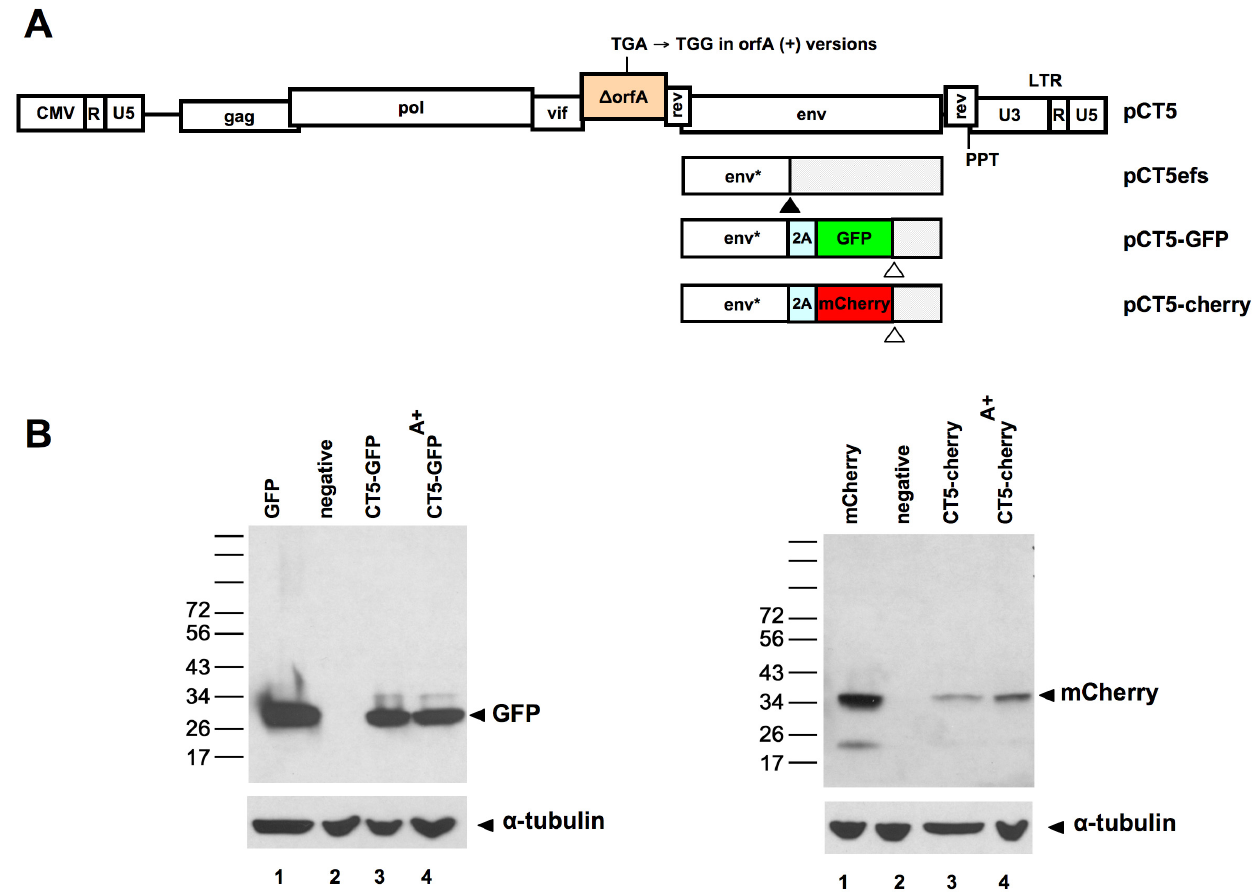
Figure 1. Virus design and testing of biological activity of restored OrfA in replicating FIV. (A) Virus genome arrangements. U3: 3’ unique element. U5: 5’ unique element. R: repeat element. PPT: polypurine tract. 2A: porcine teschovirus 2A peptide. CMV: human cytomegalovirus immediate early gene promoter. efs: envelope frame shift (black arrowhead). CT5efs has a frameshift in env , which was used as the insertion point for the 2A peptide as well. Env*: N-terminal Env protein fragment resulting from the frame shift. Open arrowheads indicate the GFP and mCherry stop codons (the env mRNA fragment distal to the stop codons is untranslated). (B) Immunoblotting demonstrates that the P2A peptide results in co-translational cleavage and generation of free GPF (left) and mCherry (right). Lane 1: cells expressing eGFP or mCherry; Lane 2: untransfected negative control; Lanes 3 and 4: reporter viruses. 293T cell lysates were harvested 48 hours after transfection and blotted with antibodies to GFP or mCherry. (C-F) Replication of viruses produced from CT5 and CT5 A+ in primary feline PBMC, feline T-cell lines Mya-1 and FetJ, and CrFK cells. Cells were not induced with any additional agents, such as soluble CD134 [34] with the exception that Mya-1 cells were maintained with human IL-2 as described in Section 3. Error bars represent standard deviation of duplicate